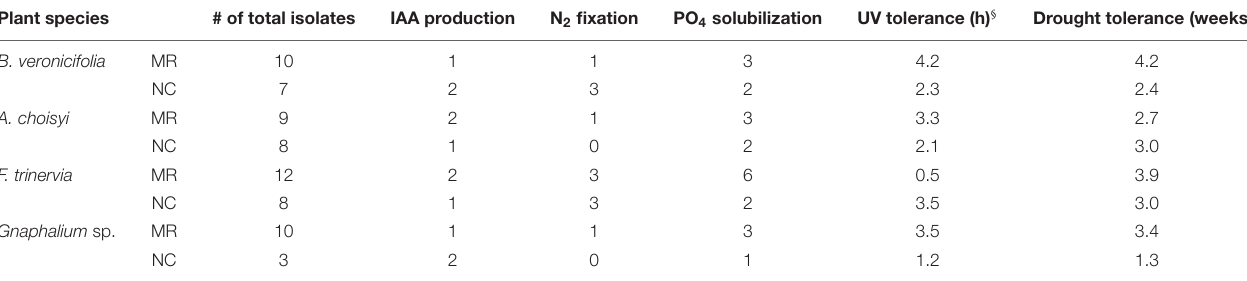
TABLE 3 | Plant growth promotion and plant protection related traits of isolated epiphytic bacteria. Plant